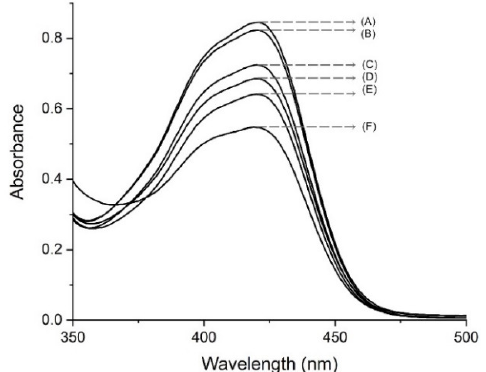
Figure 7. UV–Vis spectra of ( A ) raw chitosan, ( B ) without surfactant, ( C ) with span 80 addition, ( D ) with span 20 addition, ( E ) with tween 80 addition, ( F ) with tween 20 addition. The chitosan concen ‐ tration, surfactant concentration, and reaction time were 1% ( w / v ), 7% ( w / w ), and 24 h, respectively.